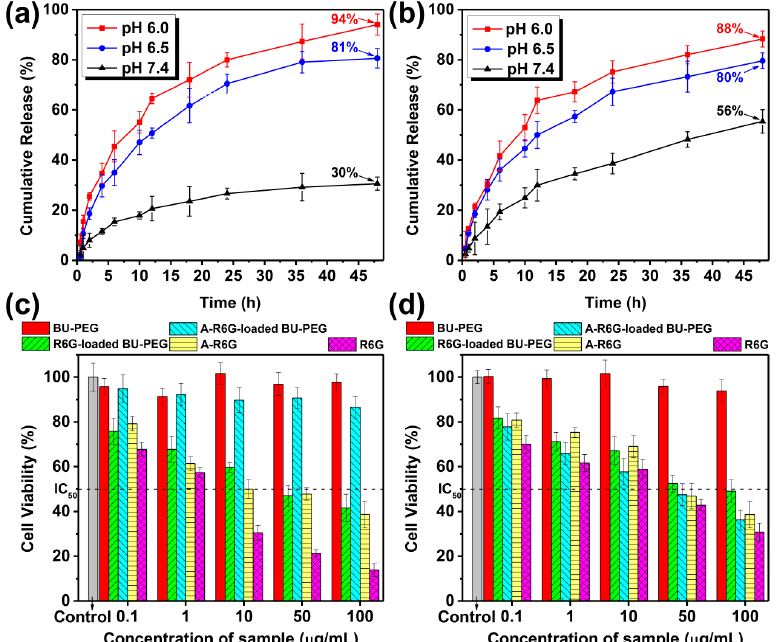
Figure 3. In vitro drug release profiles of ( a ) A-R6G-loaded and ( b ) R6G-loaded BU-PEG nanogels. In vitro cytotoxicity of A-R6G-loaded and R6G-loaded BU-PEG nanogels against ( c ) NIH/3T3 cells and ( d ) HeLa cells after 24 h incubation.